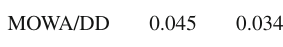
Table 8 Deviations between experimental results and the simulation data obtained by eight